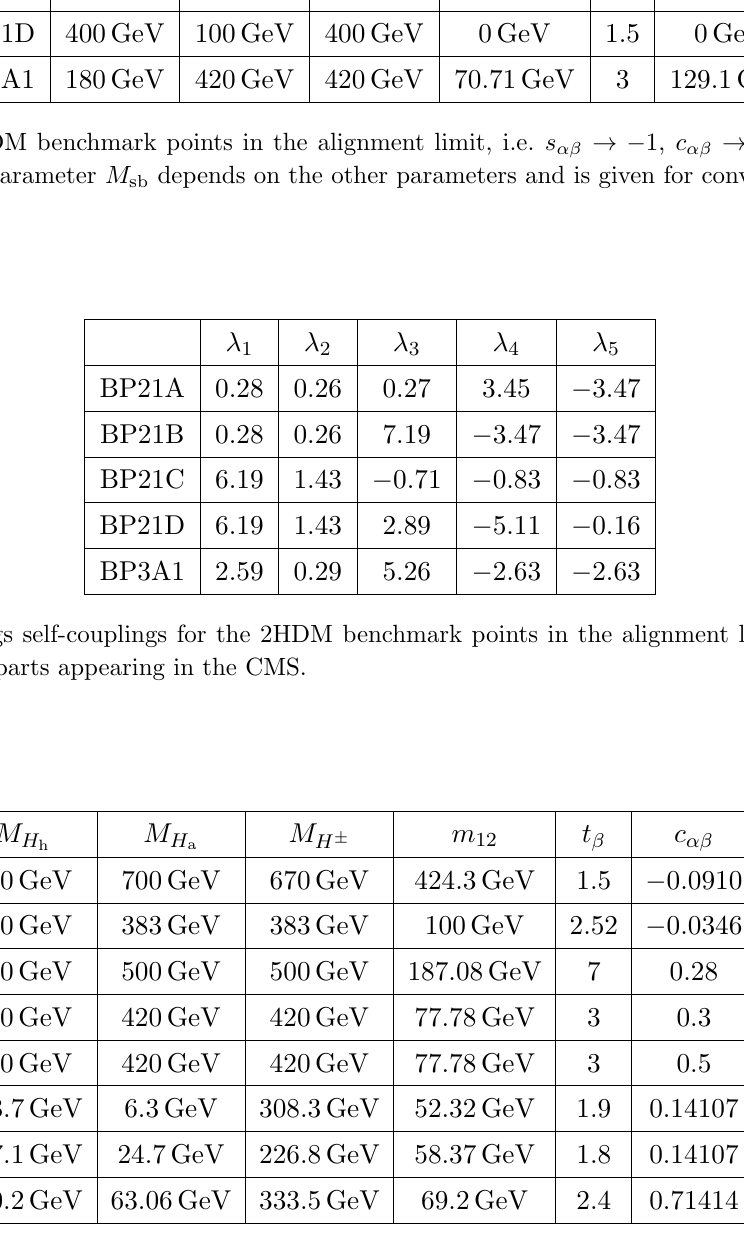
Table 3. 2HDM benchmark points outside the alignment limit taken from ref. [93] (a-1, b-1) and ref. [92]. The parameter M sb depends on the other parameters and is given for